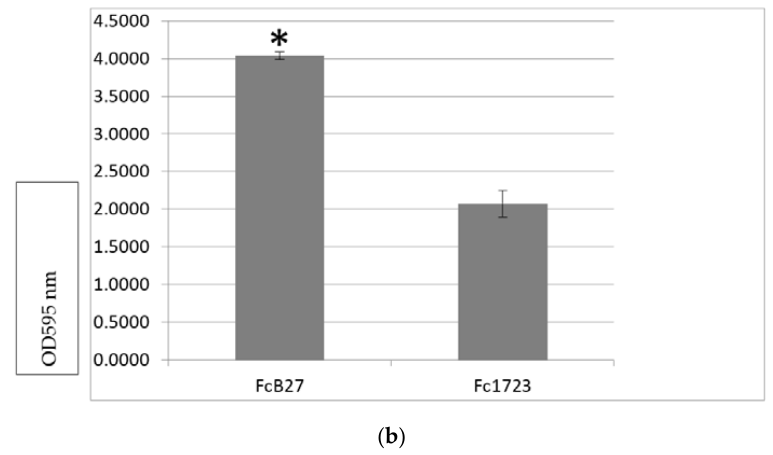
Figure 1. ( a ) Parent strain and vaccine strain growth curves. ( b ) Biofilm formation of virulent parent strain and vaccine strain after 48 h incubation in microtiter plate. * indicates significant difference.